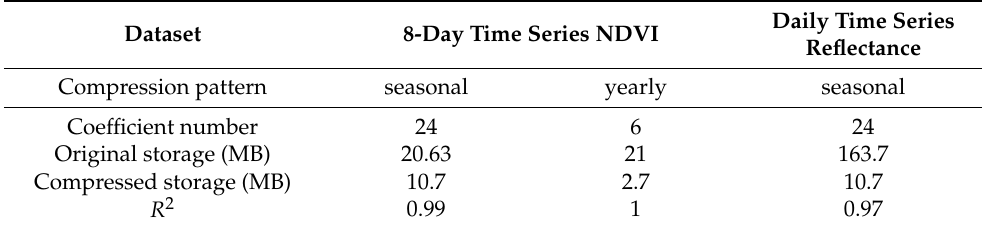
Table 4. The time series compression evaluation in two compression